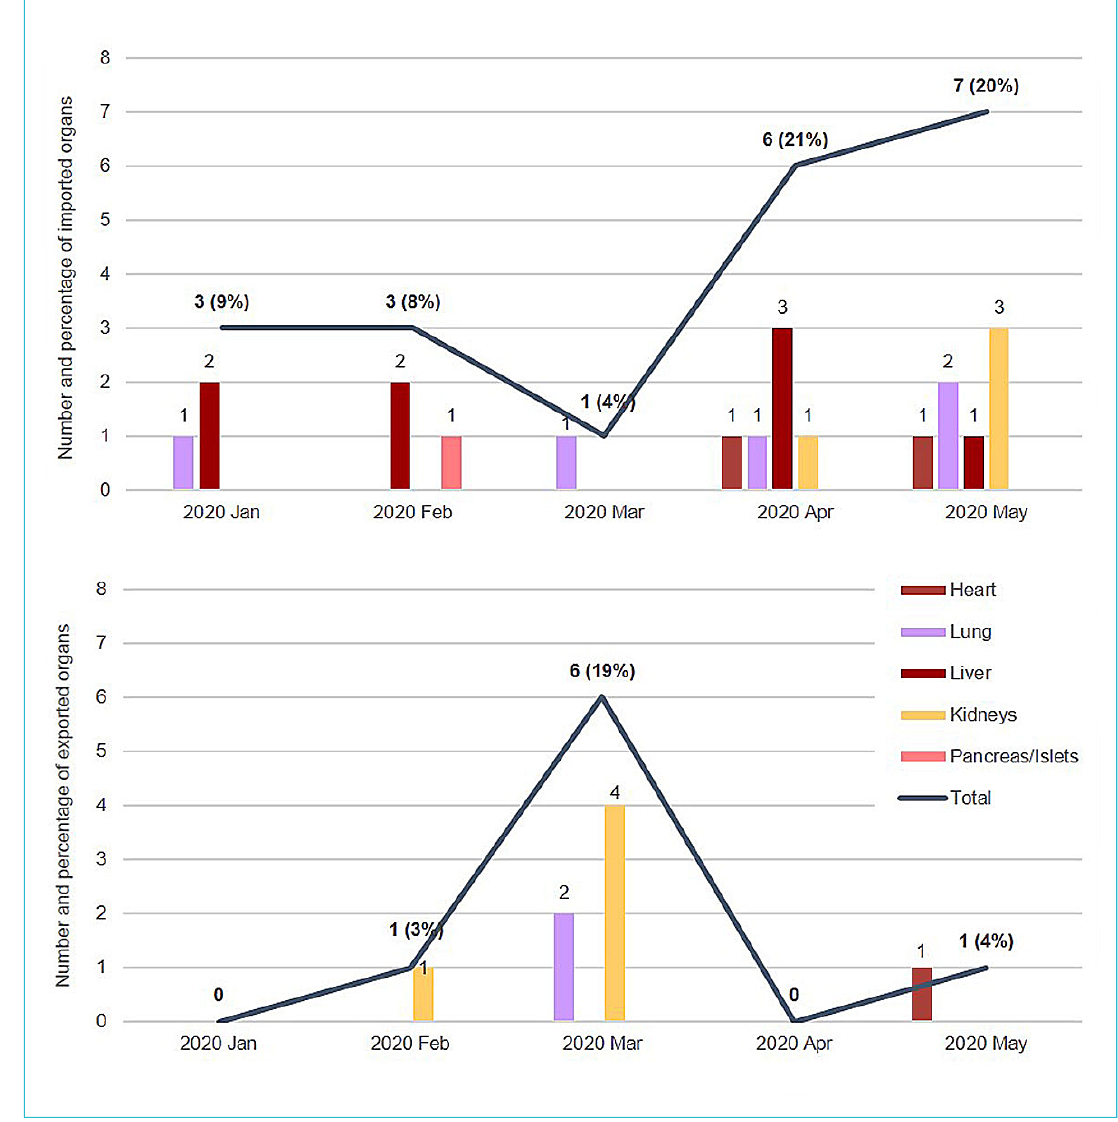
Figure 3: Number of foreign organs imported (upper chart) and exported (lower chart) over time. For total numbers, in brackets, import share in percent of all transplanted organs in Switzerland, and export share in percent of all transplanted organs from Swiss deceased donors, re- spectively, are given. From January to May 2020, organs were exchanged with France (18 organs), Italy (3 organs), Spain (2 organs), the United Kingdom (2 organs), and with Germany, Sweden, and Lithuania (1 organ